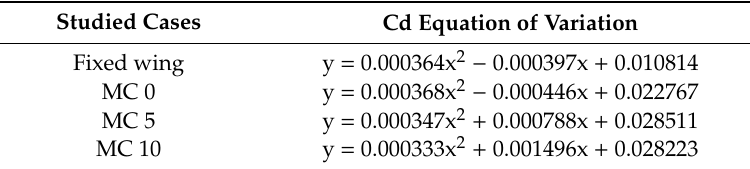
Figure 23. Drag coe ffi cient Cd variation with the angle of attack. Figure 23. Drag coefficient Cd variation with the angle of attack. Table 8. Equation of drag coe ffi cient variation with angle of attack. Table 8. Equation of drag coefficient variation with angle of attack.